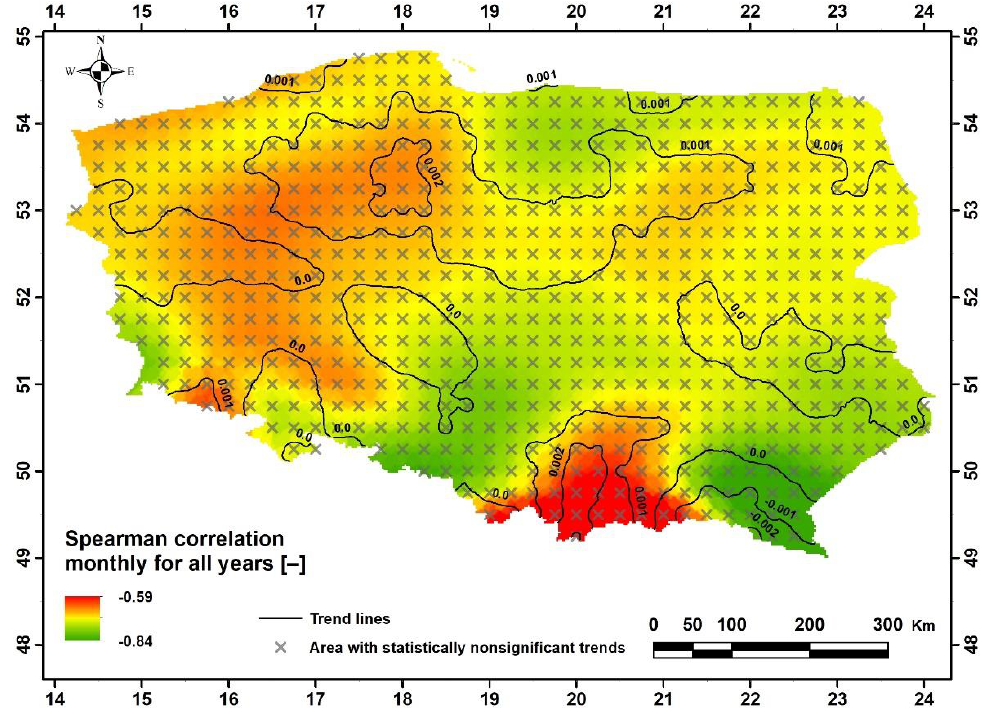
Figure 10. Complementarity between solar and wind resources based on monthly sums of resources availability, 1980–2019. Crosses show where trends (isolines) were not statistically significant.